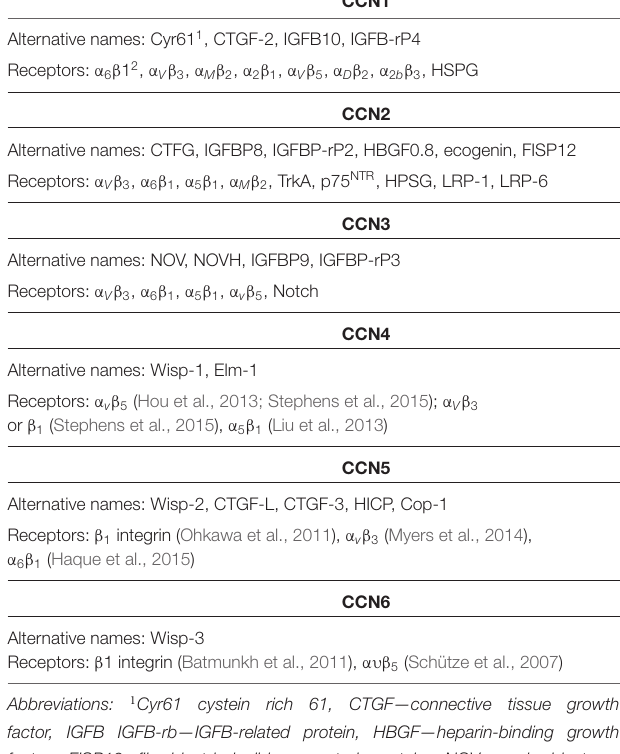
TABLE 1 | Alternative names and receptors of CCN proteins .